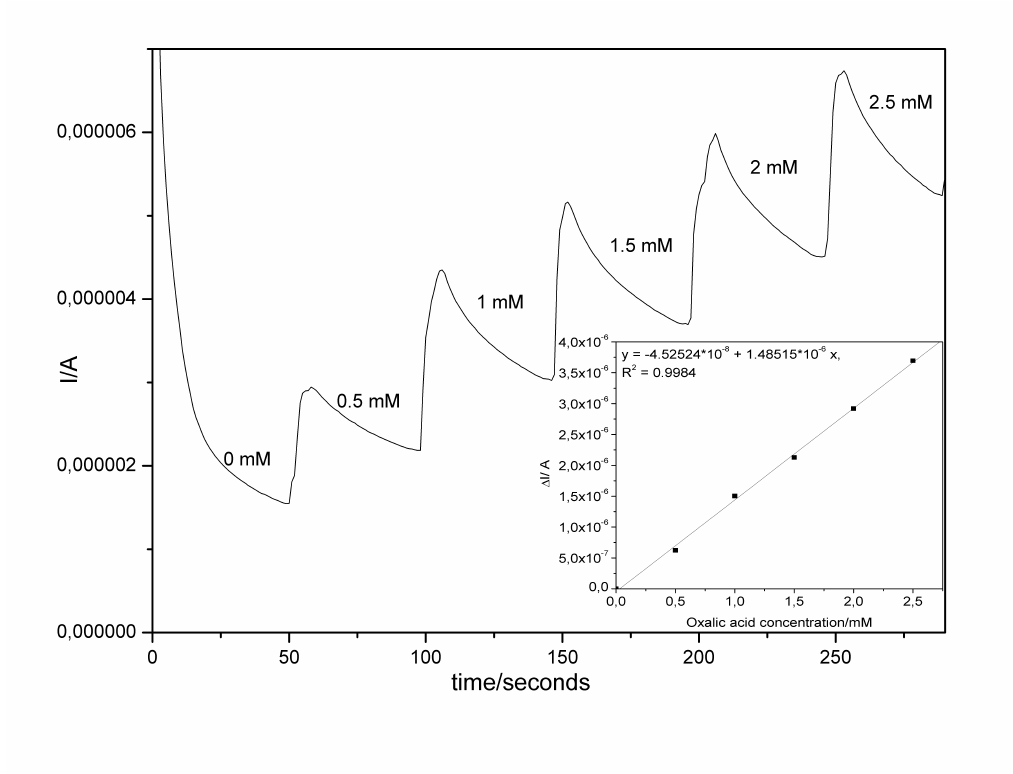
Figure 8. Amperometric response (BSA) of the EG-PS electrode for the successive and continuous addition of 0.5 mM oxalic acid. Applied potential: 1.1 V vs. SCE. Inset: calibration plots of useful signal vs. oxalic